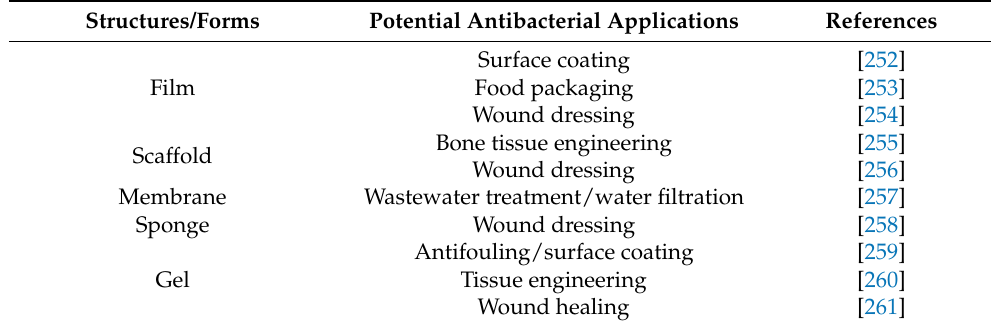
Table 4. Versatility of polymer-matrix metal nanocomposites for various antibacterial applications.